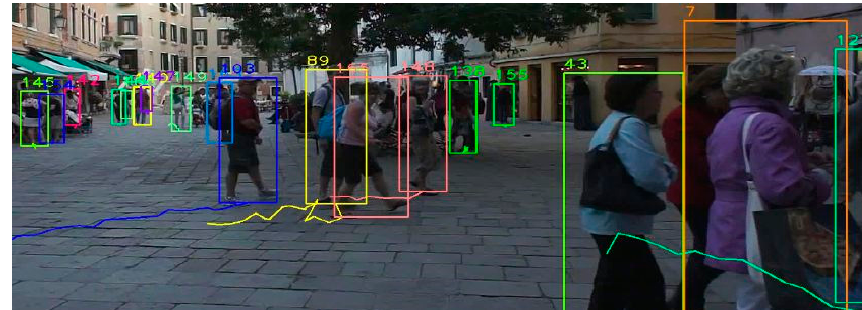
Figure 5. The proposed model (SCT) results using MOT16-02.